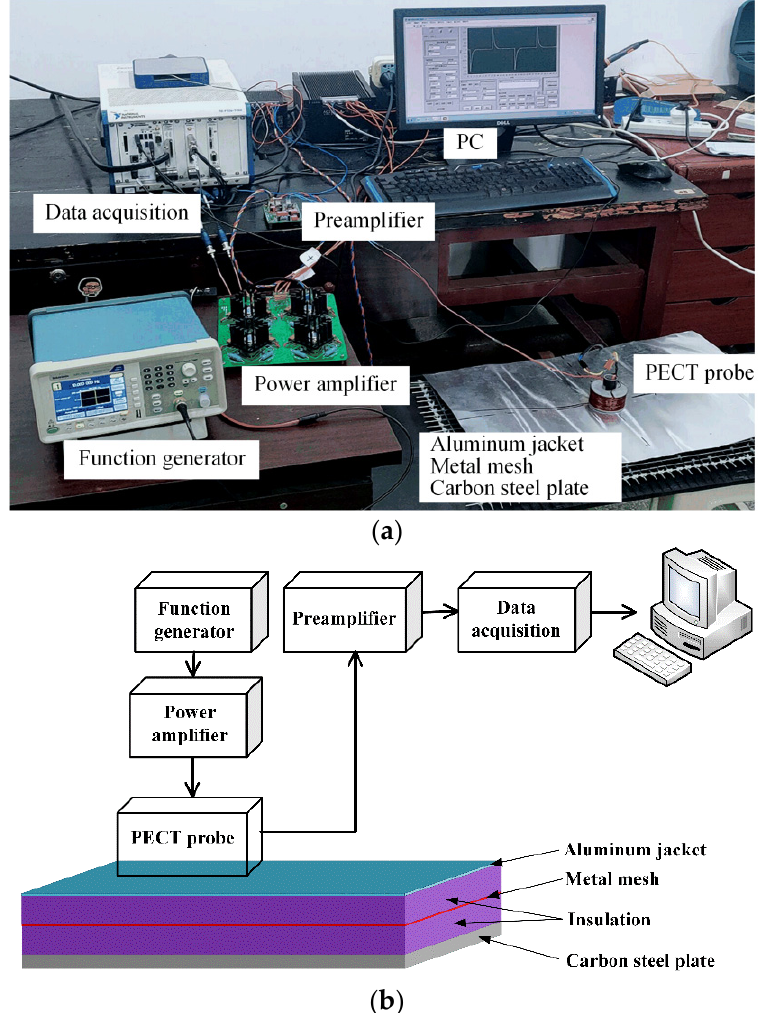
Figure 9. PECT system: ( a ) photo, and ( b ) block diagram.